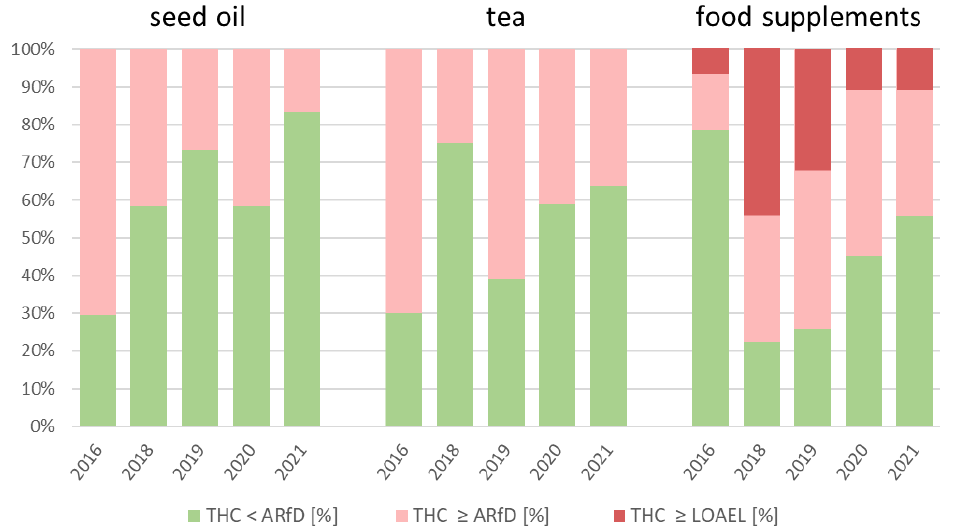
Figure 4. Percentage of the total number of samples with a daily intake of ∆ 9 -tetrahydrocannabinol (THC) exceeding the acute reference dose (ARfD) and lowest observed adverse effect level (LOAEL) for a person with a body weight of 70 kg, assuming the daily consumption shown in Table 2 for hemp tea, hemp seed oil, and hemp food supplements.